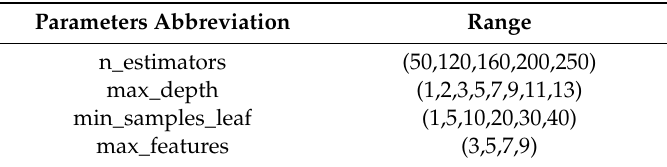
Table 1. Parameter combination range.